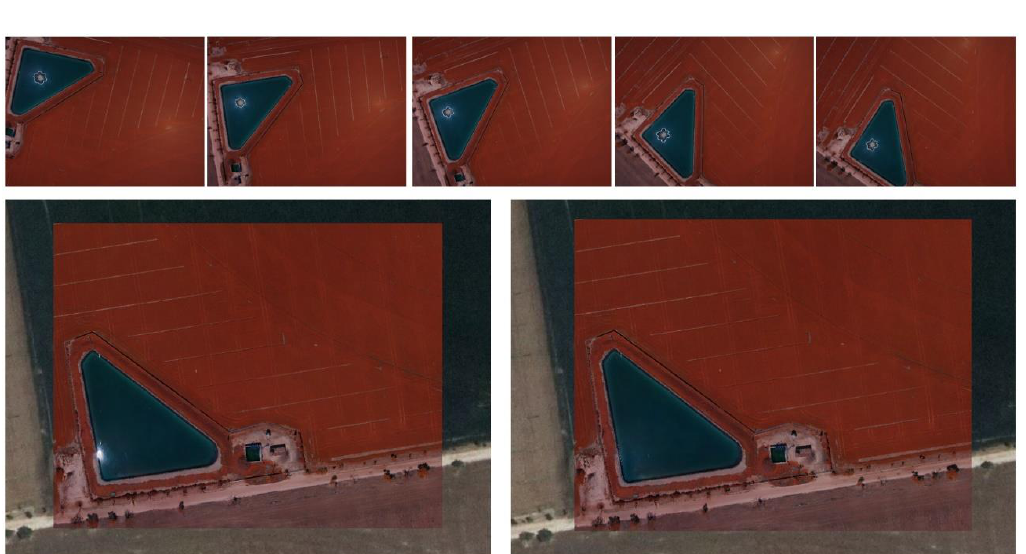
Figure 10. Near infrared orthophoto. ( Up ) detection and clustering with a mask of sun glint effects over near infrared images; ( Down ) comparison between resulting near infrared orthophoto with sun glint correction ( right ) and without sun glint correction ( left ).